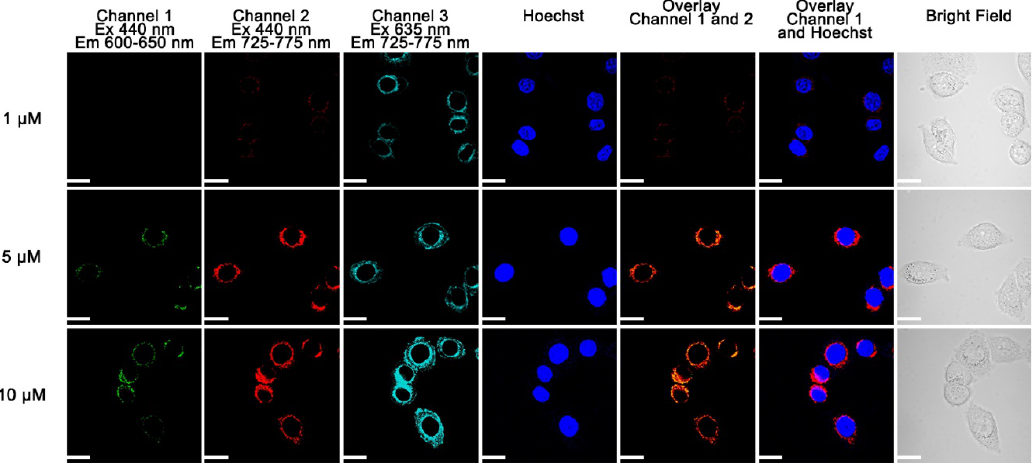
Figure 10. Live-cell fluorescence images of HeLa cells incubated with probe B + for 2 h and then with Hoechst stain for 1 h with scale bars at 20 µm. The excitation of Hoechst is 405 nm and the fluorescence collect window is from 425 to 475 nm.